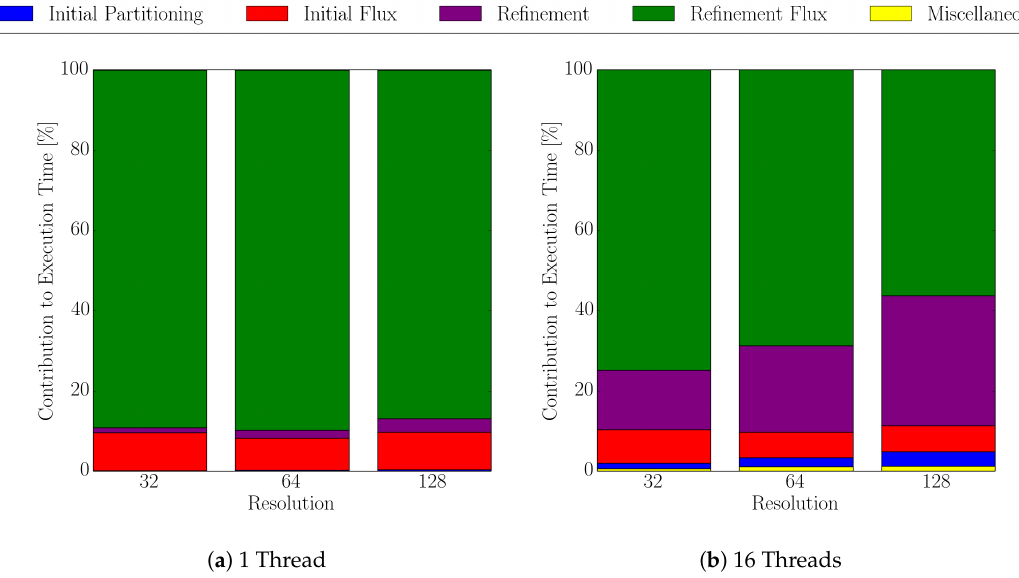
Figure 12. Contribution of the four major steps in the sparse flux calculation algorithm using 1 and 16 threads for different level-set resolutions: initial partitioning of the cells for the sparse set (blue), initial flux calculation (red), iterative refinement (purple), and the corresponding flux calculation (green). Miscellaneous (yellow) accounts for any other occurring overhead within the sparse set algorithm, e.g., computing the local flux deviations from the global maximum